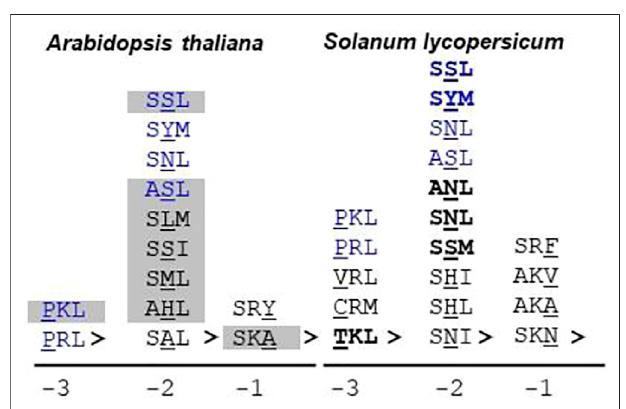
FIGURE3| Non-canonicalPTS1sequencesin Arabidopsisthaliana and Solanum lycopersicum : The non-canonical or low-abundance sequences are the ones that contain one non-canonical residue in the PTS1 tripeptide. The non-canonical residue could be present at -1, -2, or -3 positions. S. lycopersicum exhibits a greater diversity of non-canonical residues as compared to Arabidopsis thaliana . Blue text: non-canonical PTS1 present in both Arabidopsis thaliana and S. lycopersicum . Bold text: successfully predicted by the PTS1predictor algorithm (only S . lycopersicum proteins taken into account); gray highlighted tripeptide: demonstrated peroxisomal localizationby fl uorescentfusionconstruct;underlined residue:non-canonical residue; “ > ” indicates the end of the peptide sequence. The number at the bottom indicates the position of the non-canonical residue in the PTS1 tripeptide. Underlined residues are the non-canonical ones. For S . lycopersicum , no wet-lab data are